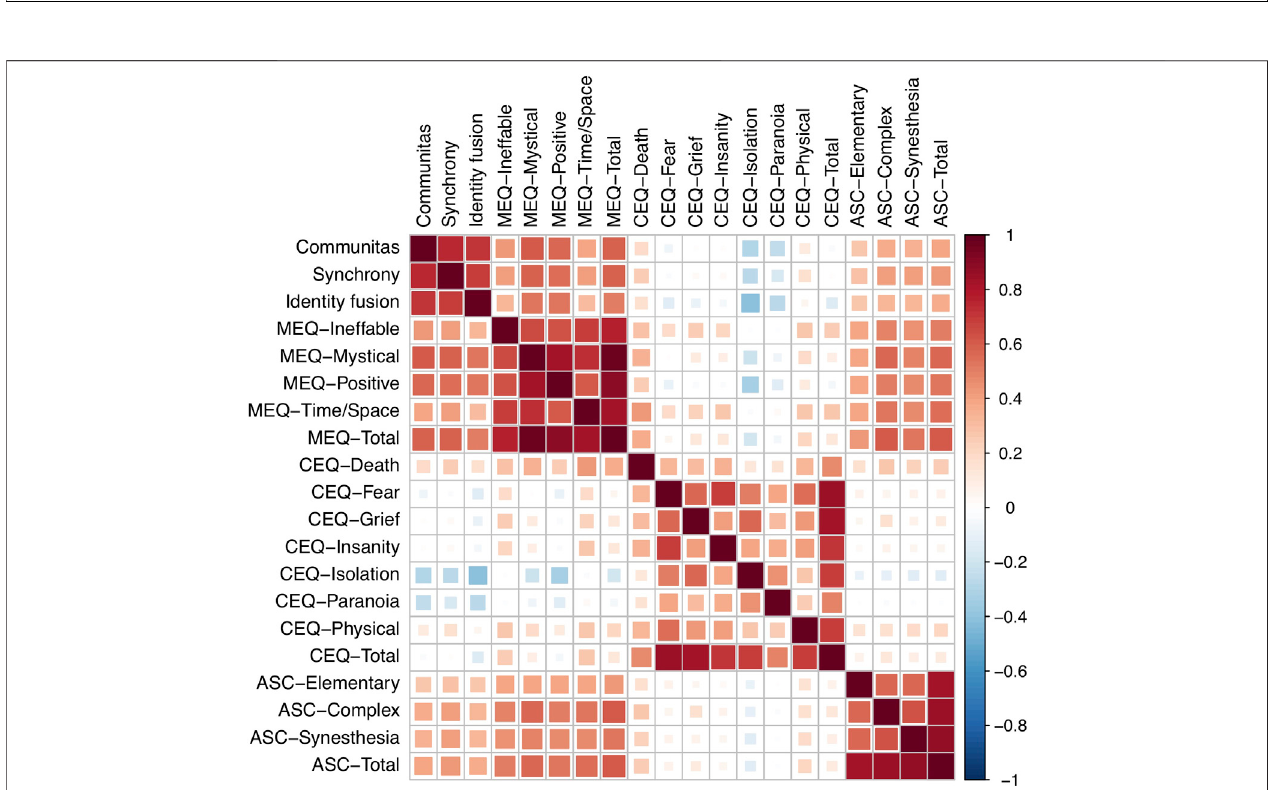
FIGURE2| Items,factorloadings,andresponsedistributionsoftheadoptedCommunitasScale(COMS).Loadingsrefertostandardizedfactorloadingsbasedon a single-factor con fi rmatory factor analysis.